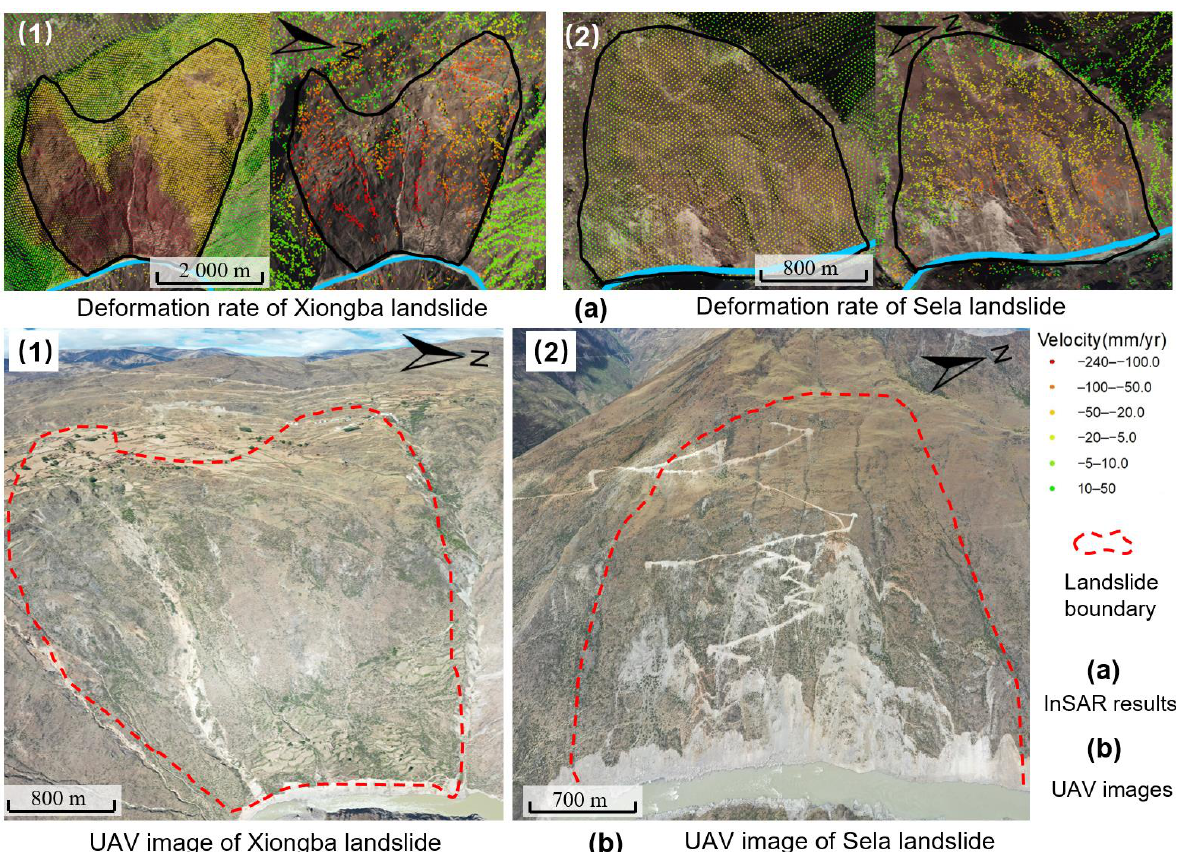
Figure 7. SBAS-InSAR and PS-InSAR deformation rate ( a ) and UAV images ( b ) of two typical active landslides. The red and black line in the figure represents the landslide boundary.